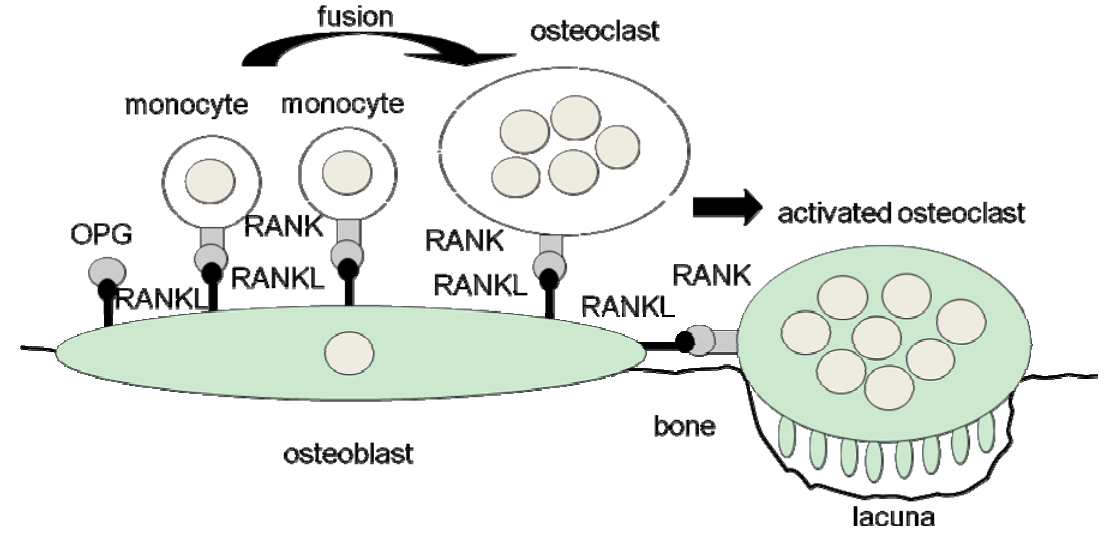
Figure 2. Differentiation and activation of osteoclasts. A RANK-RANKL system induces both osteoclastogenesis from monocytes and the activation of mature